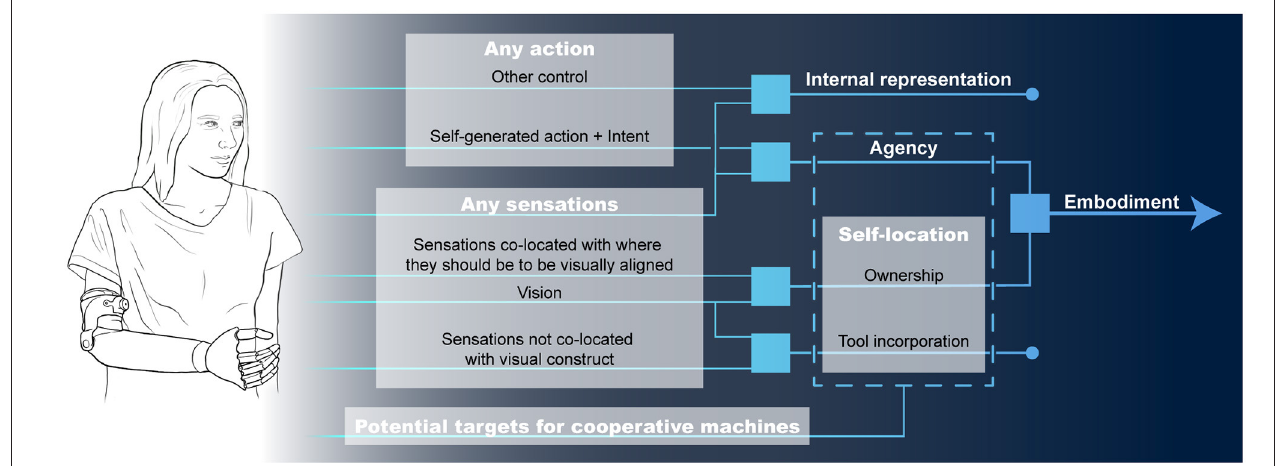
FIGURE 1 | The pieces of embodiment and potential targets for cooperative human-machine